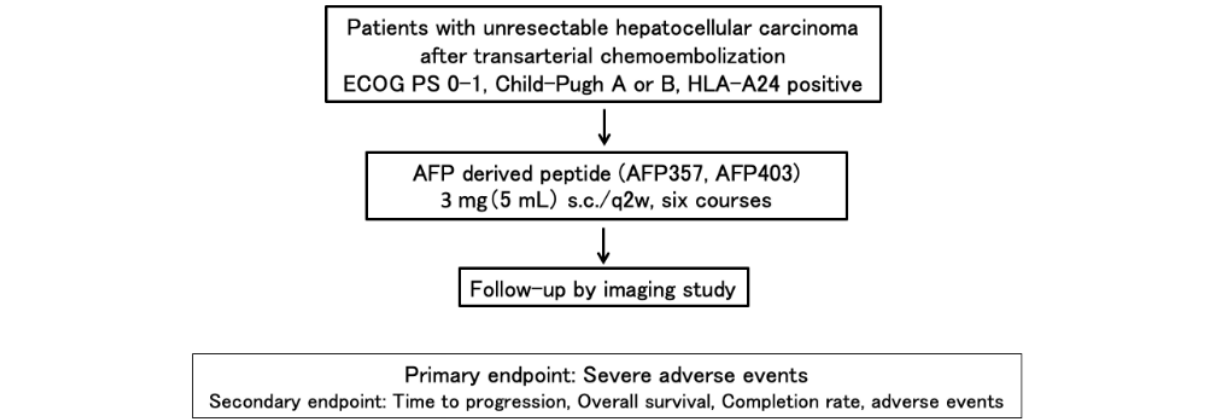
Figure 1. Diagram of study design. ECOG: Eastern Cooperative Oncology Group; PS: performance status; HLA: human leukocyte antigen; AFP: